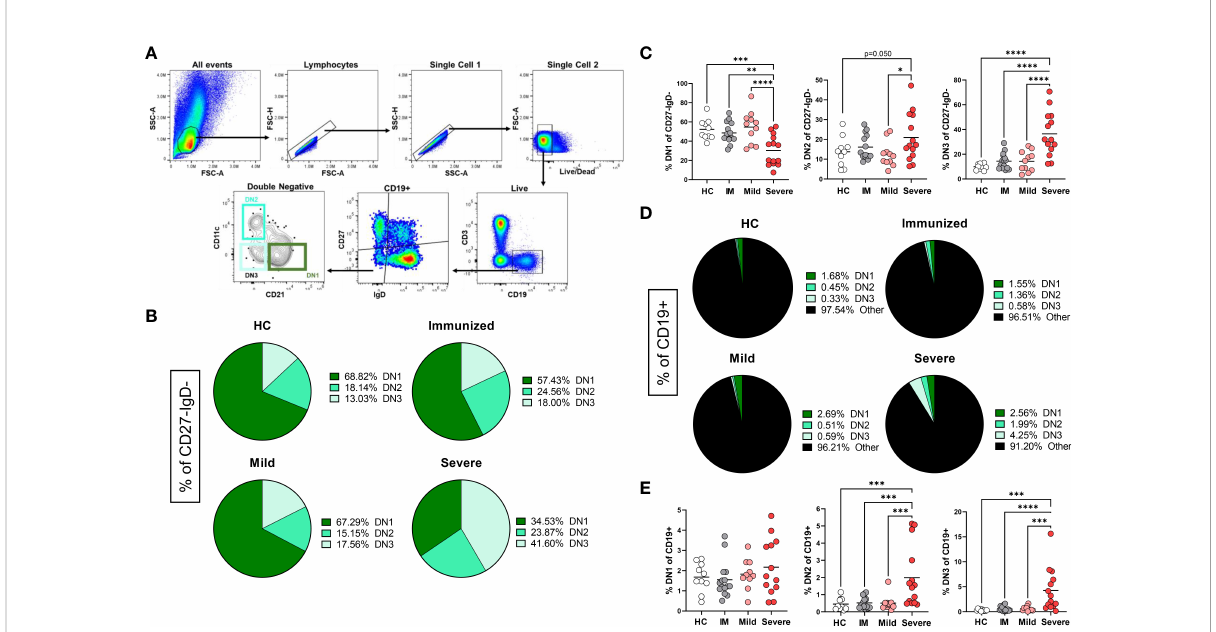
FIGURE 1 Alteration in the frequency of Double Negative subsets with Severe SARS-CoV-2 infection. (A) Flow plots demonstrating the gating strategy to identify DN1, DN2 and DN3 populations in human PBMCs. (B) Pie charts depicting the average frequency of DN1, DN2, and DN3 subsets within the total double negative population (CD27-IgD-) for healthy controls (HC), individuals immunized against SARS-CoV-2 (IM), individuals with mild or severe SARS-CoV-2 infection. (C) Quanti fi cation comparing the frequency of each DN subset within total double negative population (CD27-IgD-). (D) Pie charts depicting the average frequency of DN1, DN2, and DN3 subsets within the total B cell population (CD19+). (E) Quanti fi cation comparing the frequency of each DN subset within total B cells (CD19+) between healthy controls (HC, N=10), individuals immunized (IM, N=15) against SARS-CoV-2, and individuals with mild (N=11) or severe SARS-CoV-2 infection (N=14). Statistics: one-way ANOVA, *p < 0.05, **p < 0.01, ***p < 0.001, ****p <